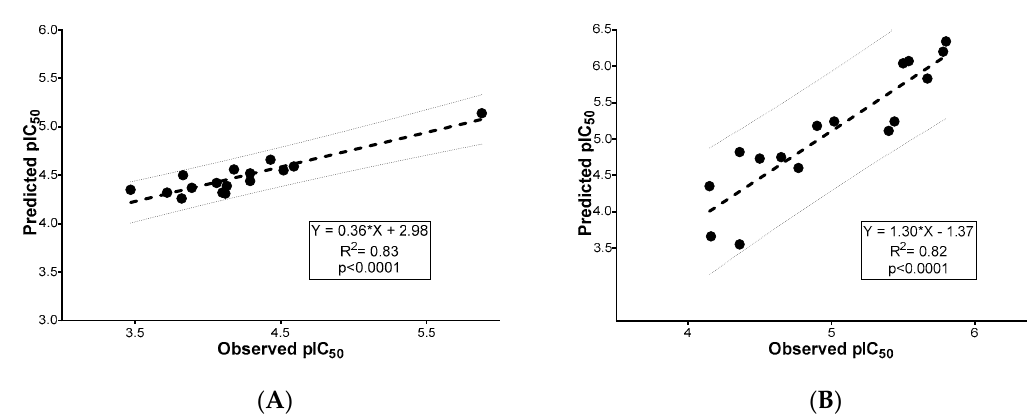
Figure 1. The linear regression between observed and predicted activity of synthesized flavone derivatives and positive control against ( A ) acetylcholinesterase (AChE) and ( B ) β -secretase (BACE-1).